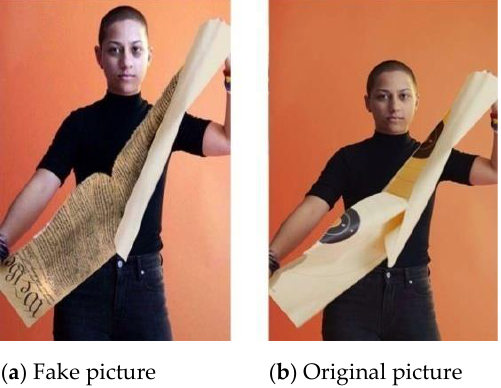
Figure 1. Two pictures: ( a ) fake picture; ( b ) original picture.